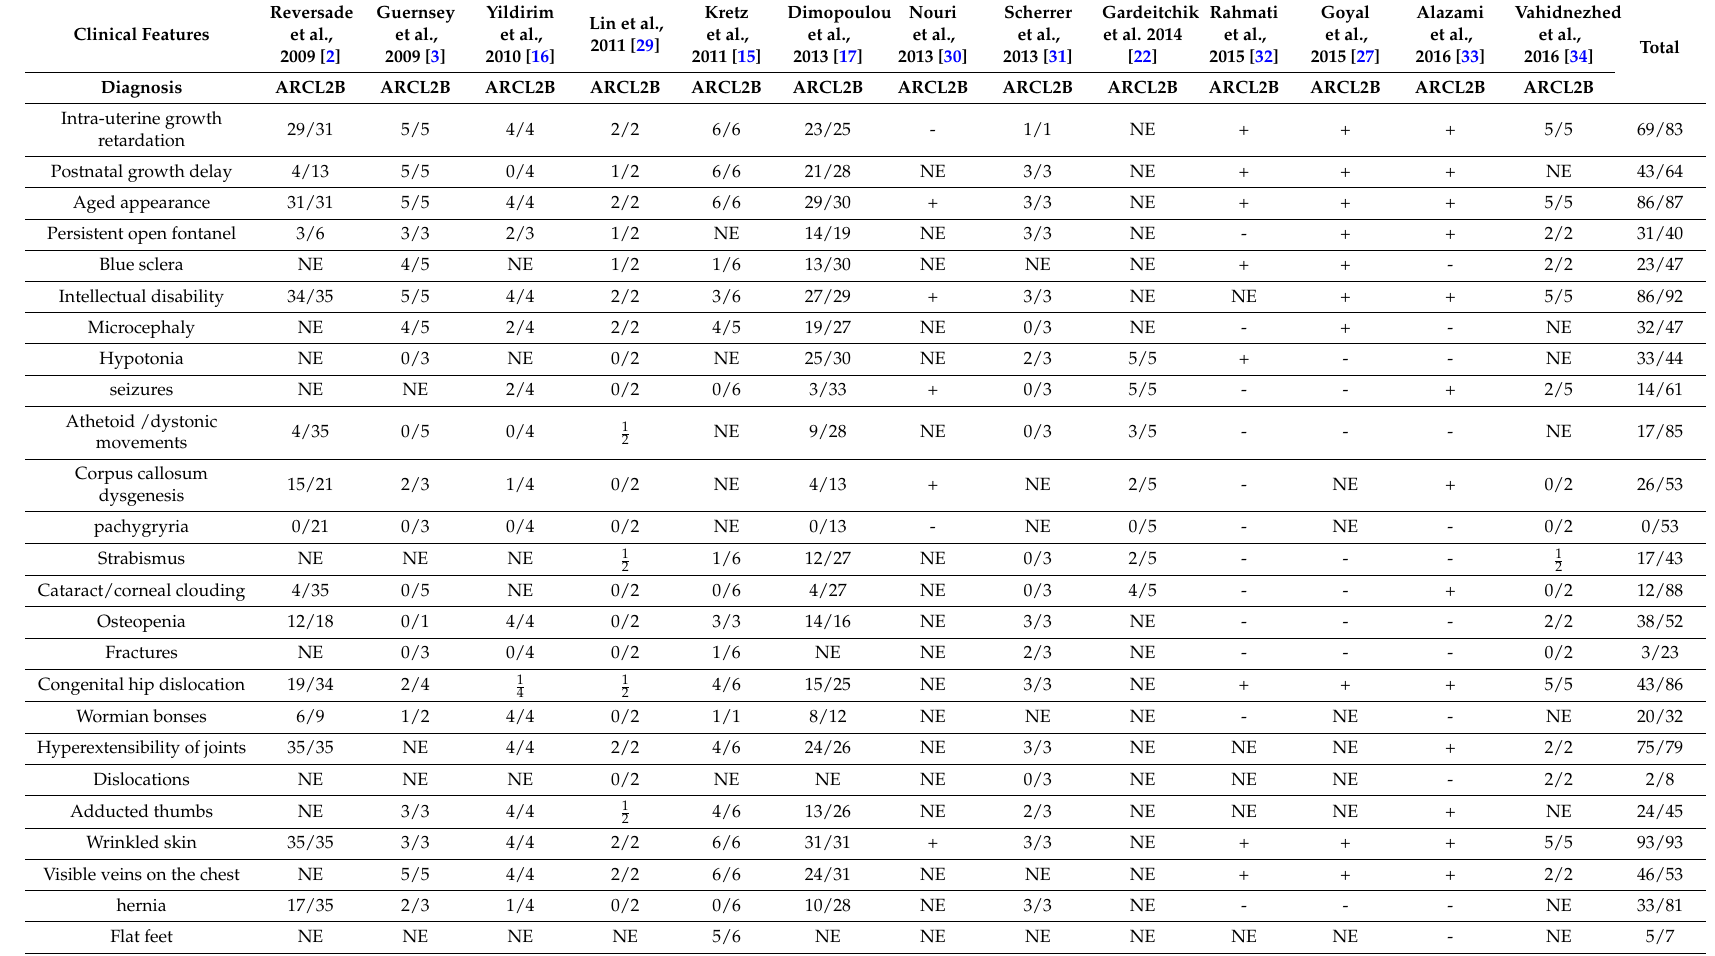
Table A2. Clinical features in autosomal recessive cutis laxa 2B patients reported in the